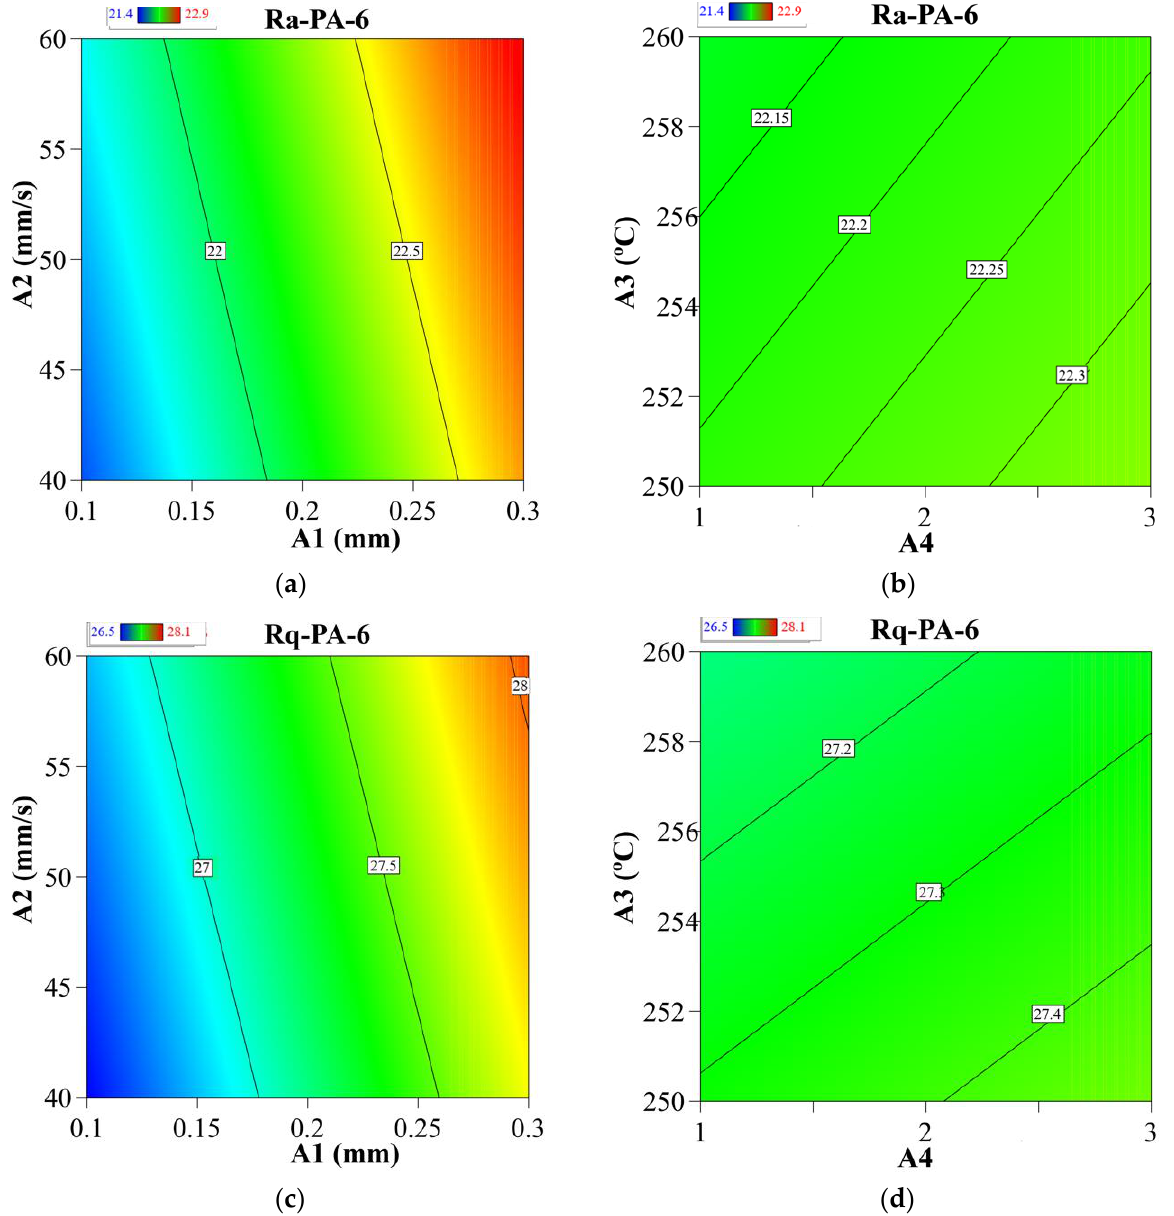
Figure 10. Contour graphs: ( a ) “A2” vs. “A1” for Ra -PA-6, ( b ) “A4” vs. “A3” for Ra -PA-6, ( c ) “A2” vs. “A1” for Rq -PA-6, and ( d ) “A4” vs. “A3” for Rq -PA-6.